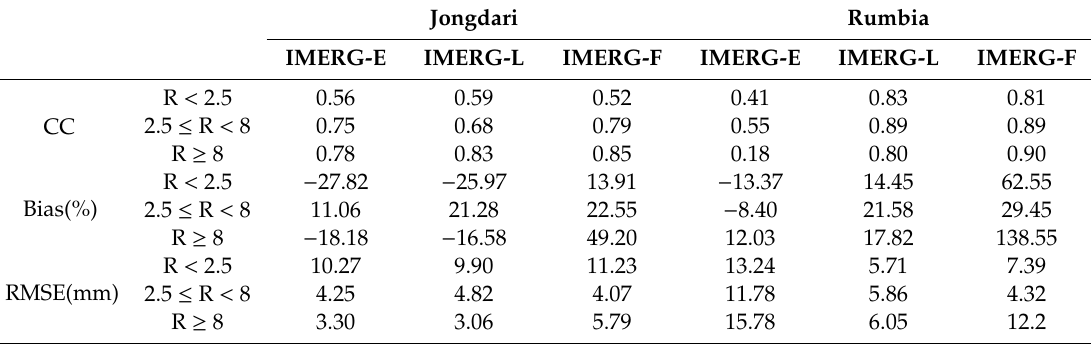
Table 4. Statistical metrics of satellite rainfall products for frequency at di ff erent intensities within the YRD. Bias, RMSE, and CC represent mean bias, root mean square error, and correlation coe ffi cient, respectively. Jongdari